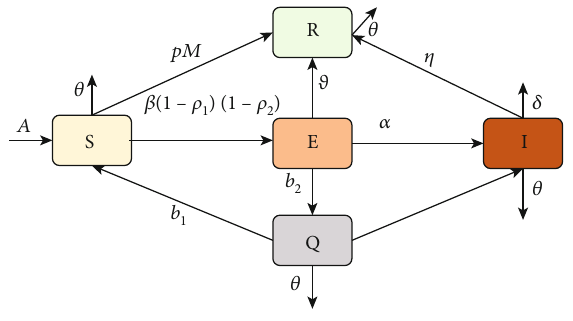
Figure 1: Compartment model for COVID-19.